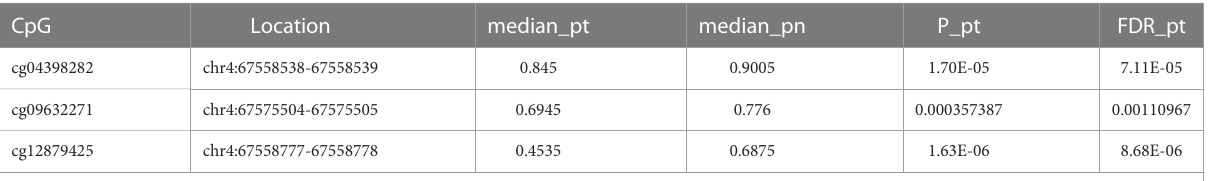
TABLE 2 Methylation level of STAP1 between cancer tissues and adjacent tissues. CpG